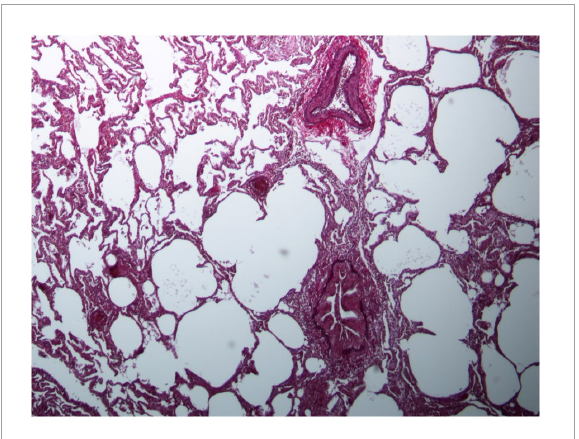
FIGURE3 Lung biopsy in patient with MDA5-positive myositis representing with chronic inflammation and subpleural